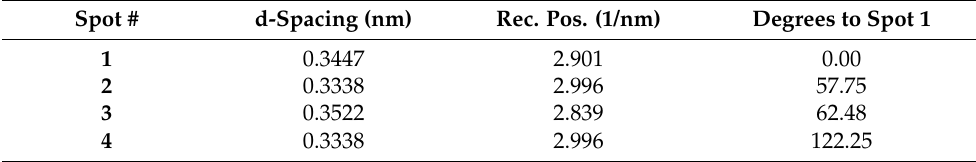
Figure 3. Structural characterization of the Cu 2 Se thin films. ( a ) The high-resolution transmission electron microscopic (TEM) image of the cross-sectional view of the thin film. ( b ) Fast Fourier-transform (FFT) of the TEM image in ( a ). ( c ) Inverse Fourier-transform of (060) crystal plane. ( d ) High-angle annular dark-field (HAADF) imaging technique in scanning TEM (STEM). ( e , f ) X-ray energy spectrum (EDS) analysis maps of Cu and Se taken from the Cu 2 Se. Table 1. d-Spacing values for the 4 local diffraction spots corresponding to the image.